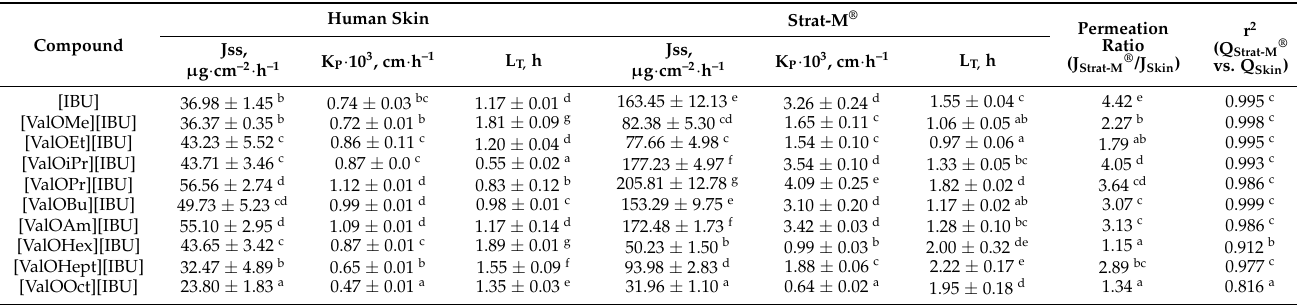
Table 4. Permeability parameters for transport of ibuprofen and its derivatives through transdermal diffusion test model and human SC in vitro. Human Skin Strat-M Compound